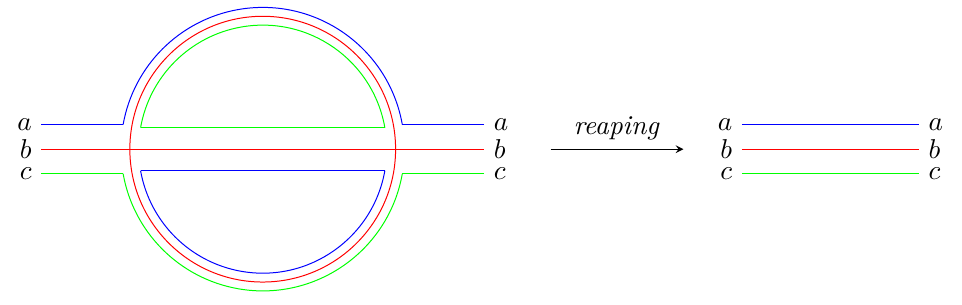
Figure 3 . Fundamental melon in the tensor model. From the maximal diagram on the left, we reap the melon and the overall scaling stays the